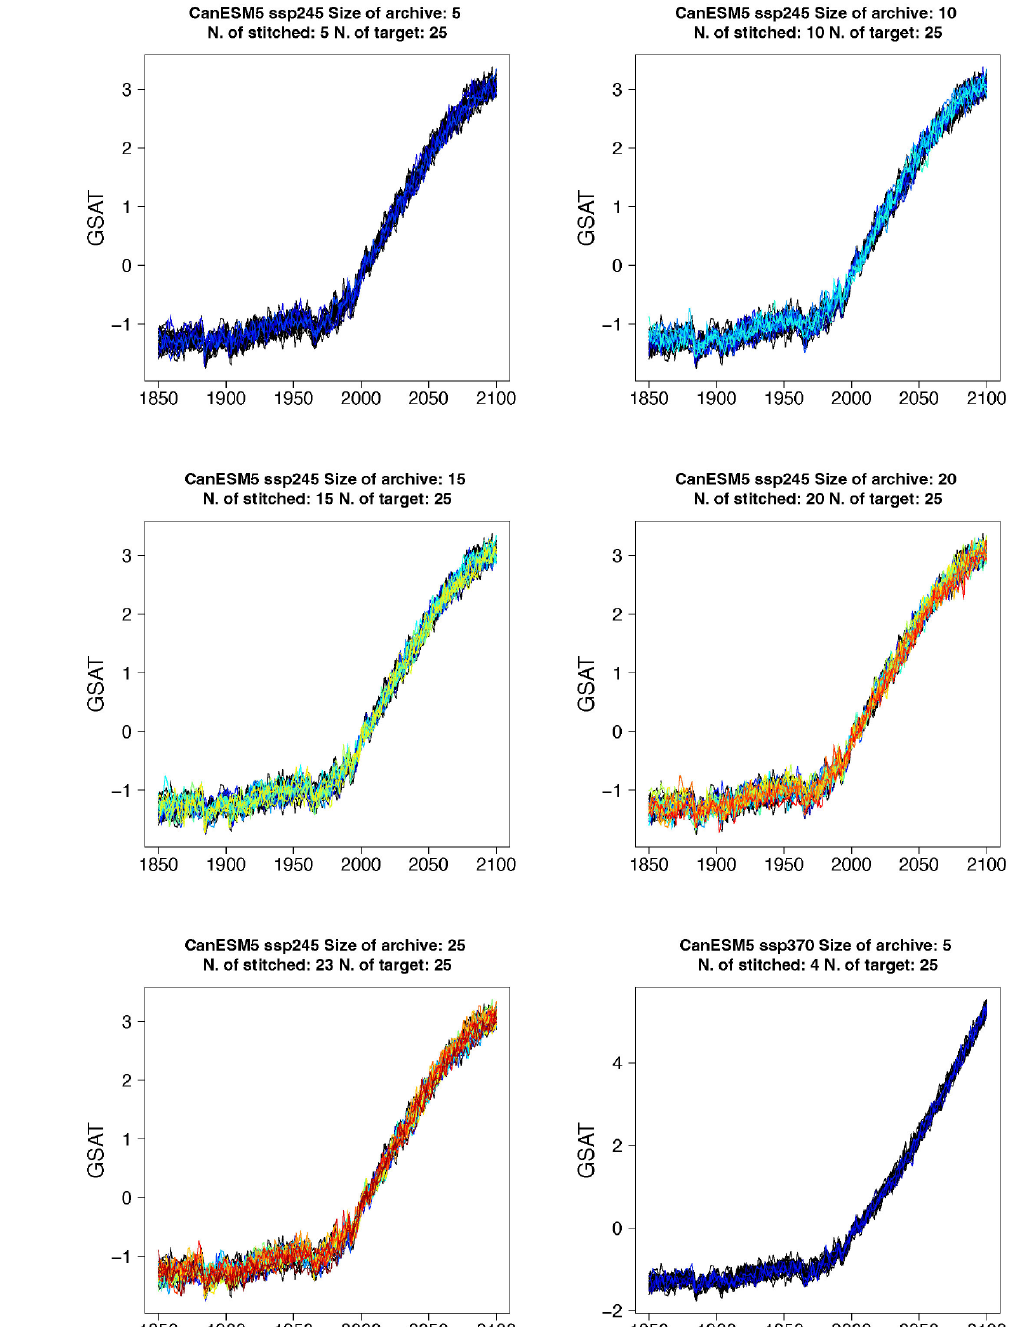
Figure E2. Examples of enriched ensembles of GSAT time series for ESMs in the PANGEO archive that have at least five trajectories available over the 21st century. As in the figures in Appendix A, warmer colors indicate a larger number of stitched trajectories in the figure, as the title also